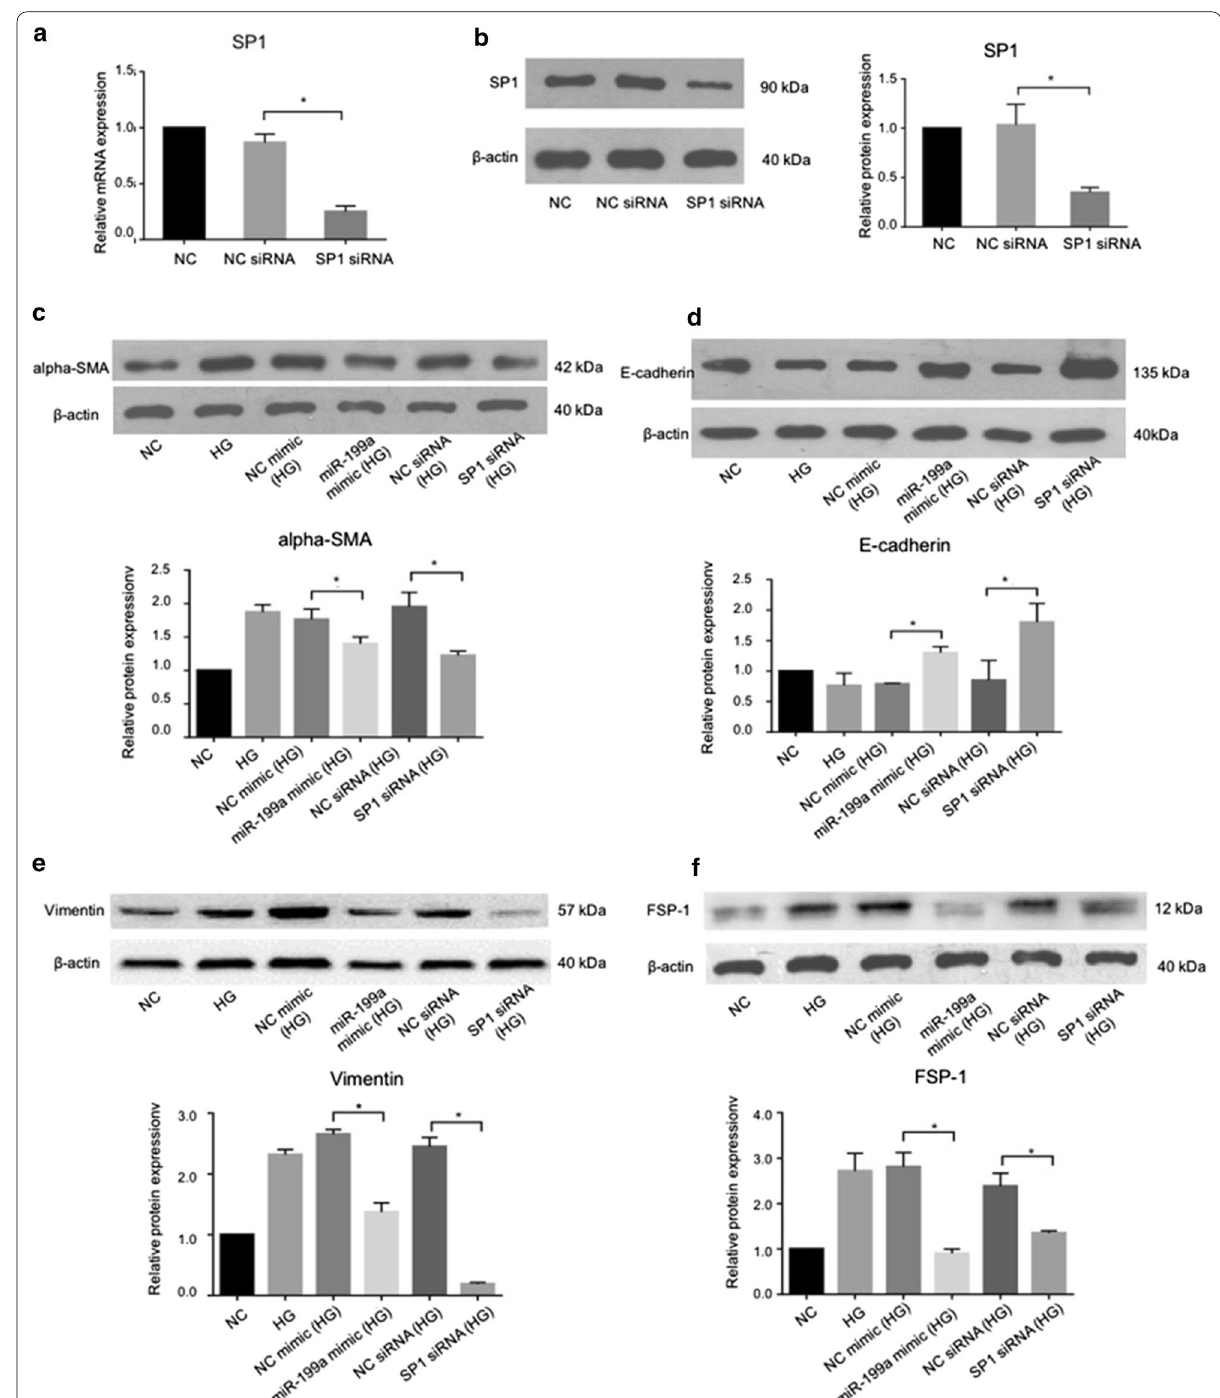
Fig. 3 MiR-199a repressed EMT through SP1 in hyperglycemic LECs. a , b SP1 mRNA and protein expression were significantly decreased by SP1 siRNA transfection (n 6). c–f After miR-199a mimic transfection, the protein expression of alpha-SMA, vimentin and FSP-1 was downregulated = compared with NC mimic in HG condition, while the E-cadherin was upregulated. When SP1 siRNA was transfected, alpha-SMA, vimentin and FSP-1expression decreased while E-cadherin expression increased (n 6). SP1 specific protein, HG high glucose, LECs lens epithelial cells. * P < =